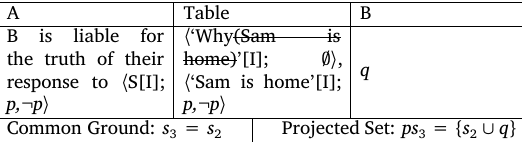
relative to the input